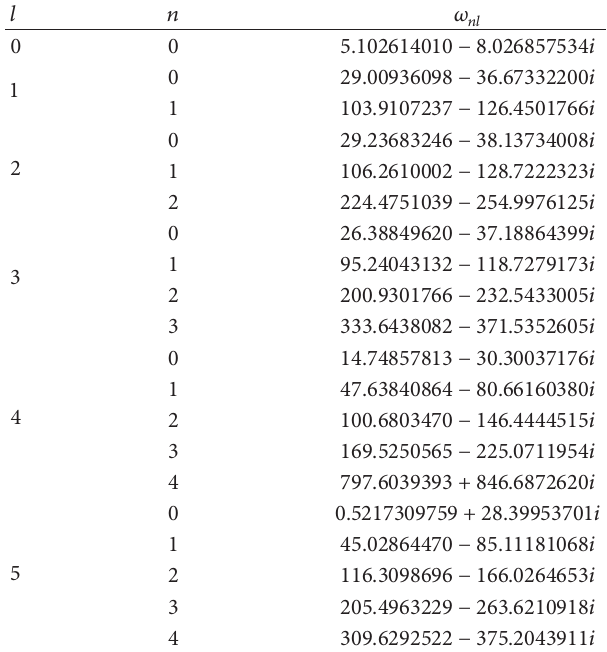
Table 3: Quasinormal modes of massive scalar perturbations for = 0.677 and 𝜇 = 0.1𝑀 with 𝑀 = 1 𝛼 0